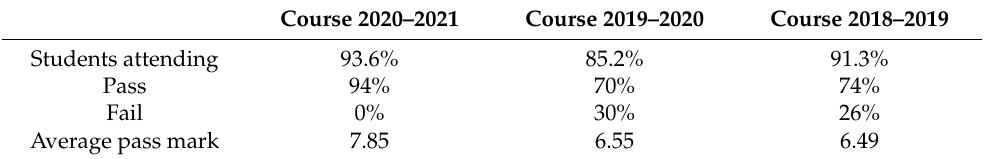
Table 10. Results of Ordinary Exam